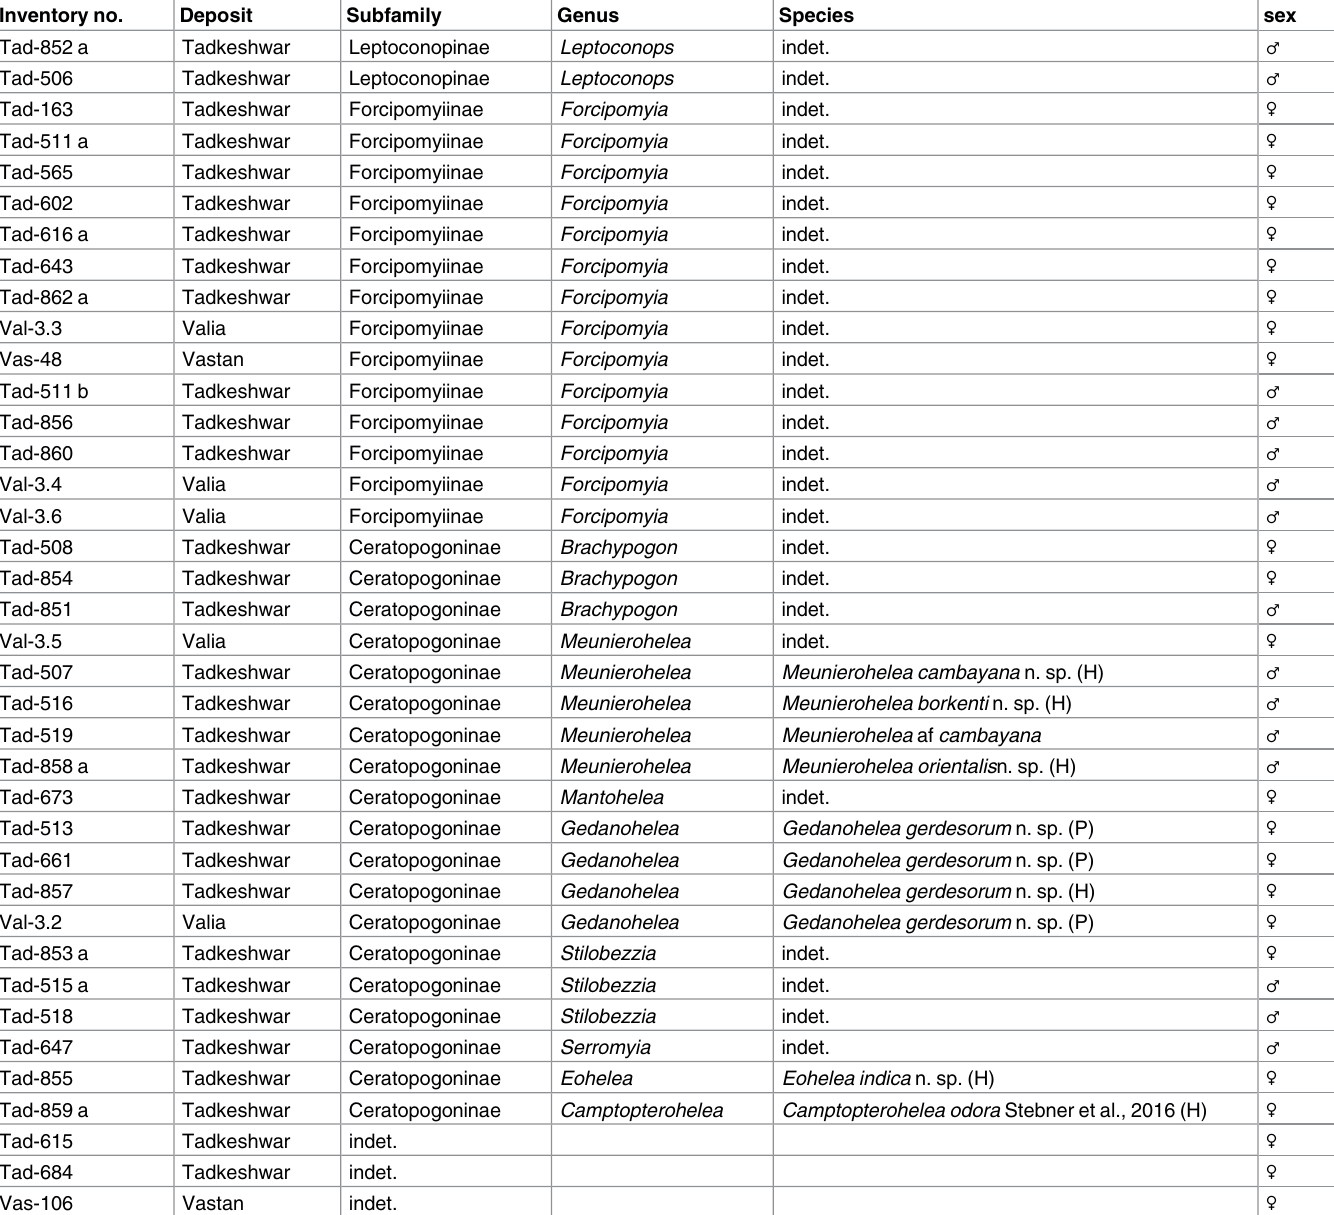
Table 1. Ceratopogonidae in Cambay amber, deposited in the collection of the American Museum of Natural History. Abbreviations: H = holotype, P = paratype. Inventory